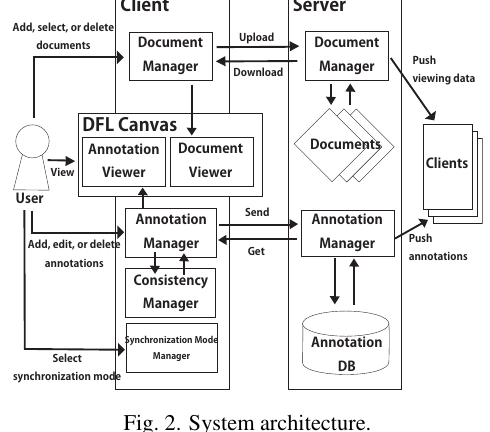
Fig. 2. System architecture.